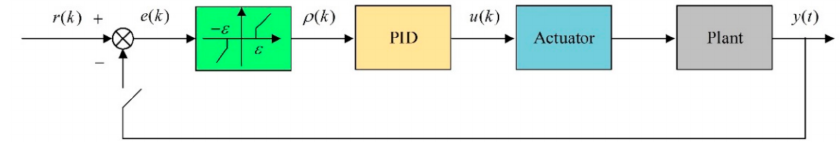
Figure 10. PID with